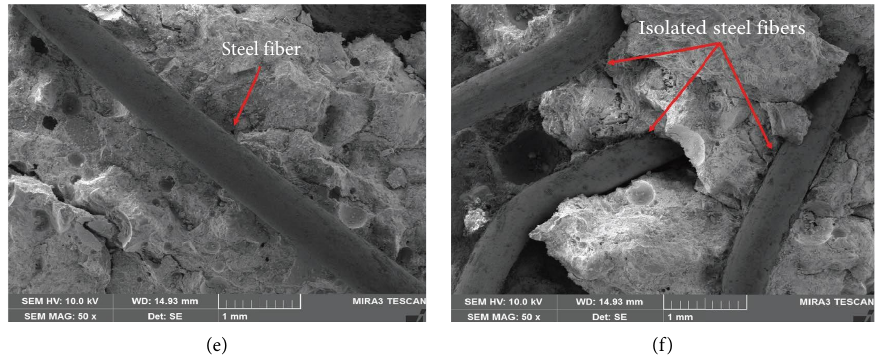
Figure 10: SEM images with diferent CF volume fractions of (a) CF10 (200x), (b) CF30 (200x), (c) CF40 (200x), (d) CF60 (200x), (e) SF25 (50x), and (f) SF125 (50x).